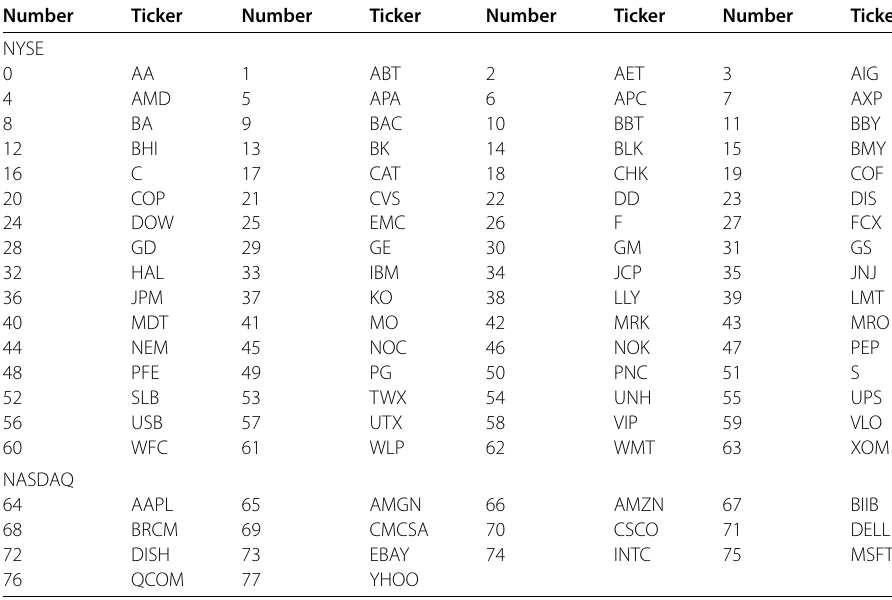
Table 1 Ticker that corresponds to stock number in Figure 2